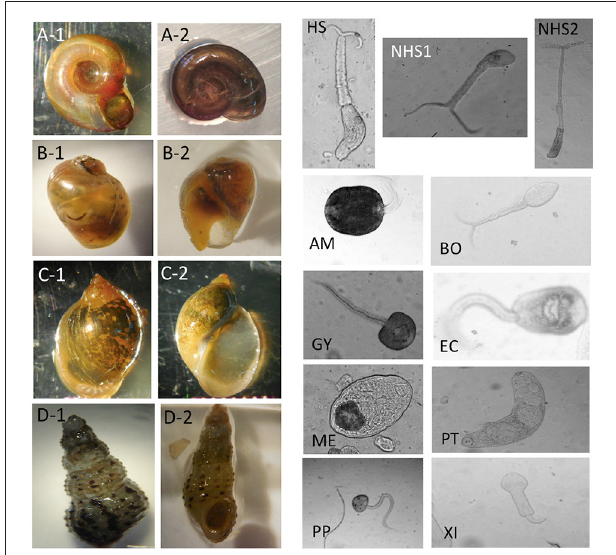
FIGURE 2 | Image examples for snail and parasite categories. For snail categories, (A-1,A-2) : Biomphalaria . (B-1,B-2) : Bulinus . (C-1,C-2) : Radix natalensis . (D-1,D-2) : Melanoides spp. For parasite categories, HS, Human-schisto; NHS1, Nonhuman-schisto forktail type I;